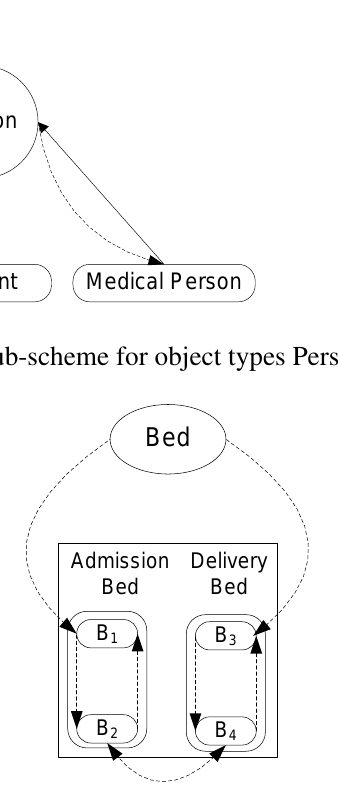
Figure 8. ORM sub-scheme for object type Bed